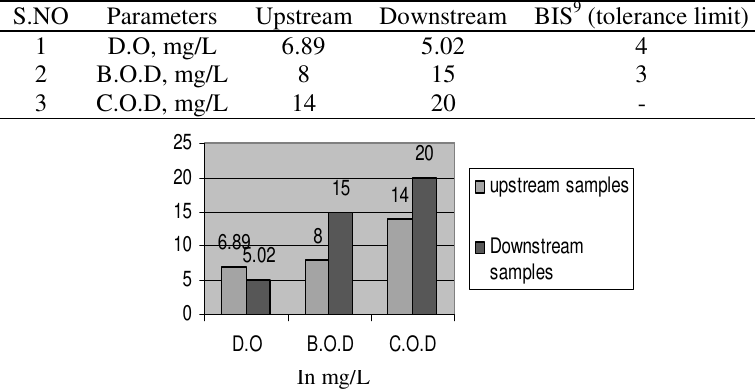
Figure 3. DO, BOD and COD (in mg/L) upstream and downstream samples.